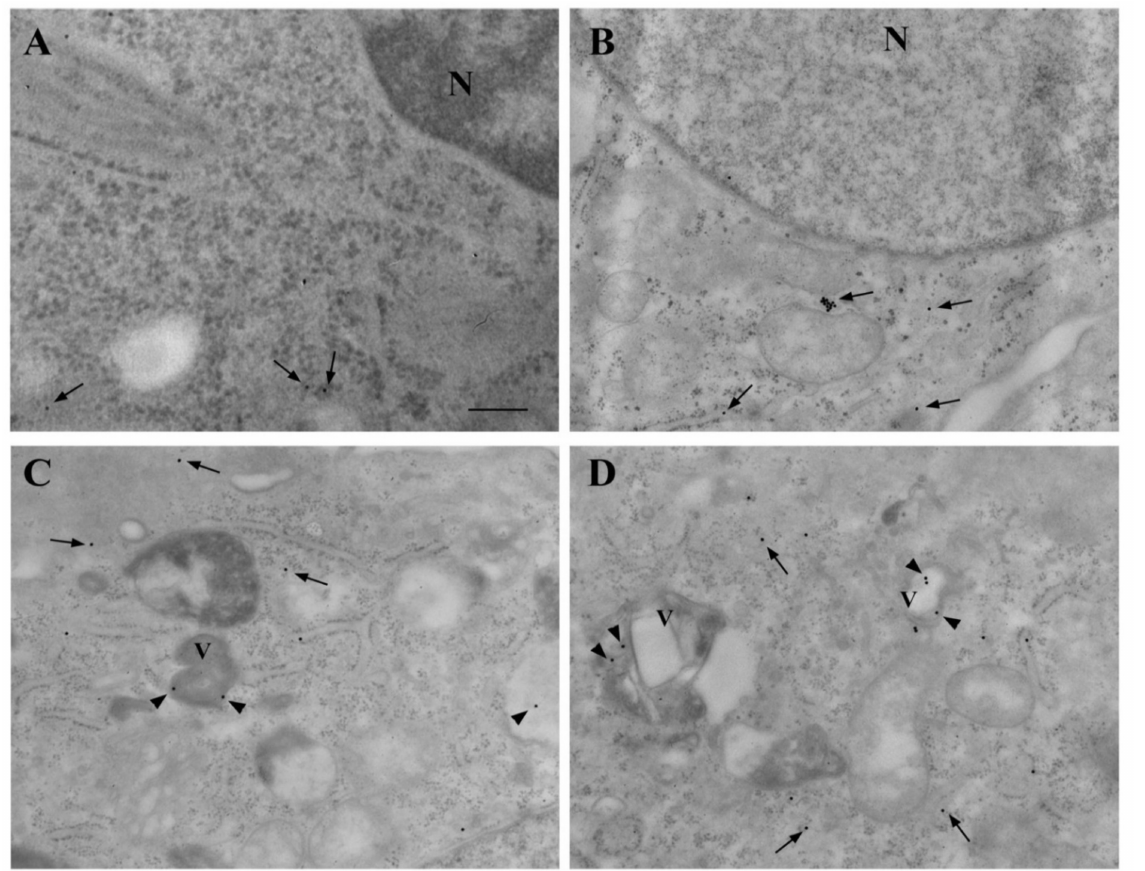
Figure 16. Rapamycin-induced vacuolar compartmentalization of PK-resistant α -syn in U87MG cells. Representative micrographs show the presence of PK-resistant isoform of α -syn within astro- cytes ( A ) and U87MG ( B – D ) cells, in baseline conditions ( A , B ) and following rapamycin exposure (Rap 10 nM and Rap 100 nM, ( C , D ), respectively). Arrows = α -syn immuno-gold particles in the cytosol; arrowheads = α -syn immuno-gold particles within vacuoles. N = nucleus; V = vacuole. Scale bar = 0.28 µ